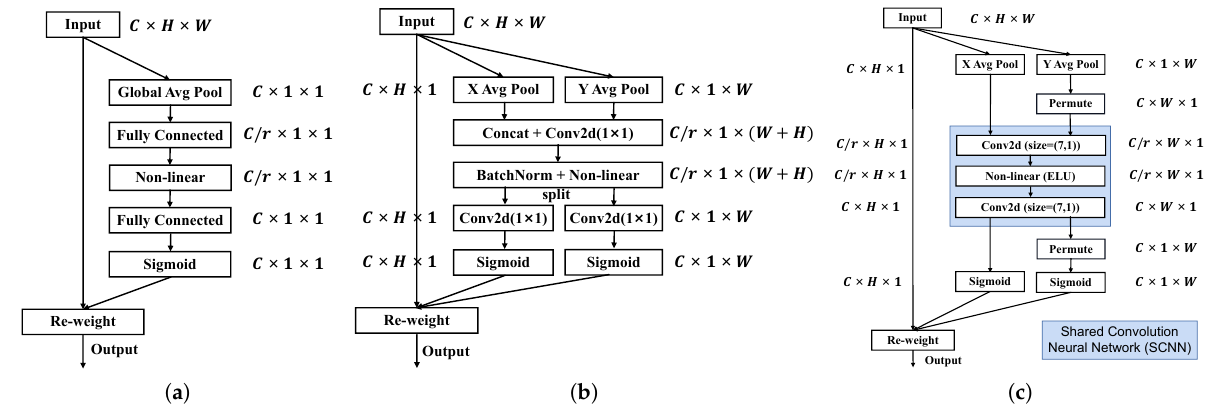
Figure 5. Schematic comparison of the classic SE attention ( a ), coordinate attention ( b ), and the proposed attention module ( c ). Here, ‘X Avg Pool’ and ‘Y Avg Pool’ represent two pooling layers with kernel size of (1, W) and (H, 1),